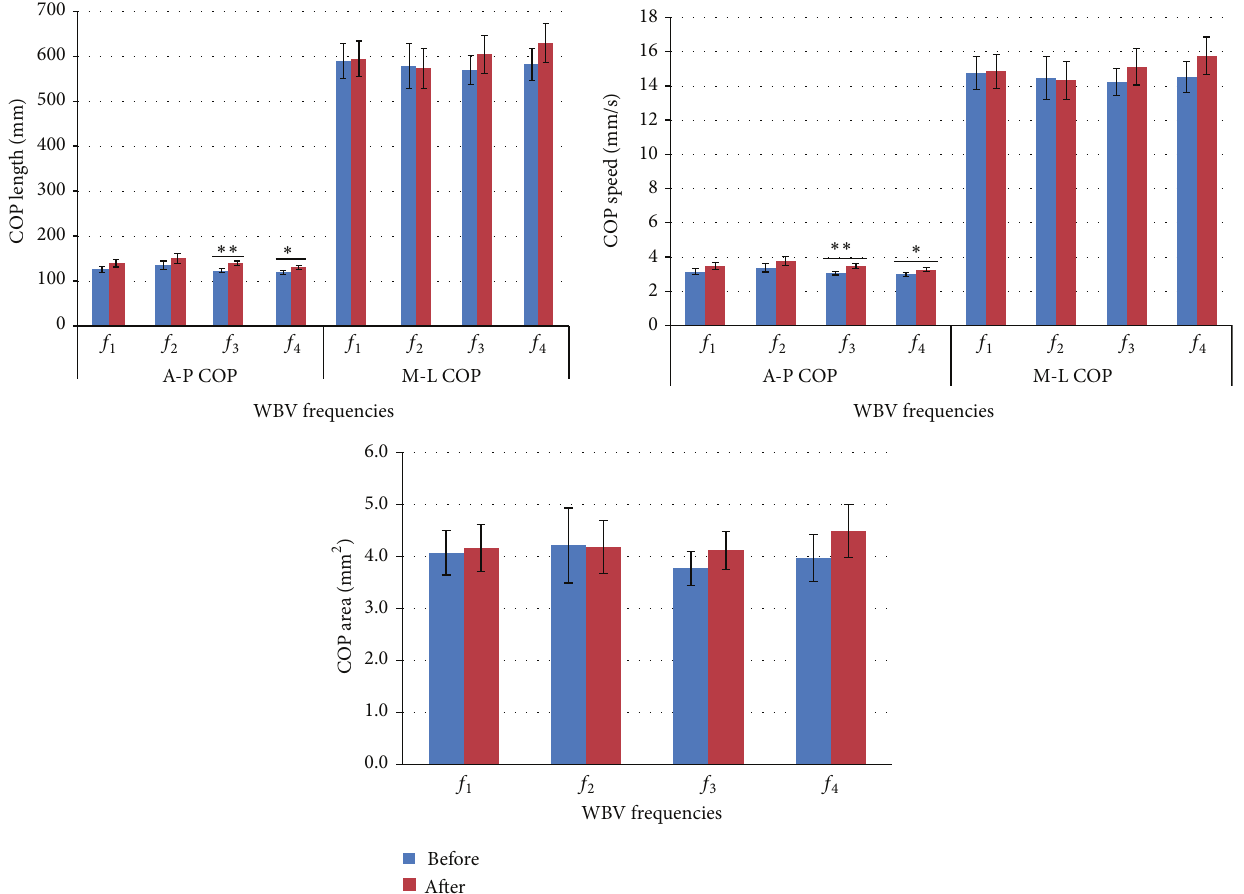
Figure 3: Mean and standard error values of the COP summary measures during the 60-second single leg stance trials for the different frequency WBV groups, before and 20 minutes after WBV intervention. 𝑓 1 = 31 Hz; 𝑓 2 = 35 Hz; 𝑓 3 = 40 Hz; 𝑓 4 = 44 Hz ( 𝑛 = 17 ) ( ∗ 𝑃 < 0.05 ; ∗∗ 𝑃 < 0.01